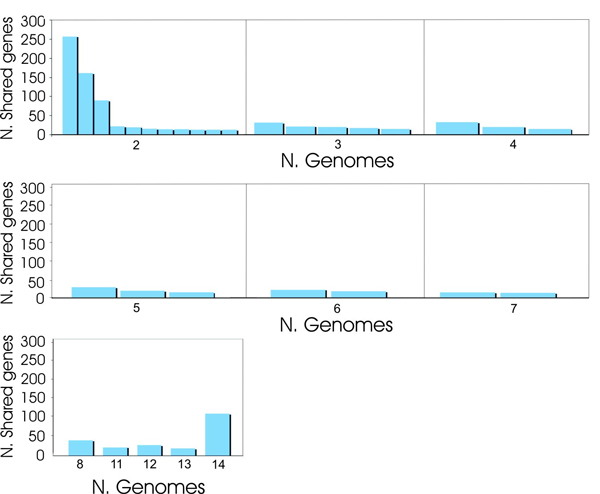
Number of gene clusters identified only in Vibrionaceae family; the number of Vibrionaceae genomes is reported on the x axis and the amount of shared genes is reported on the y axis. In the first histogram, for example, there are 11 groups of Vibrios each composed by 2 genomes.